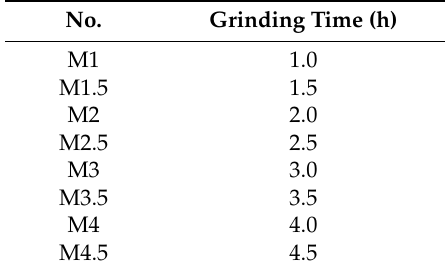
Table 2. The experimental layout of the mechanical grinding of copper-mine tailings.